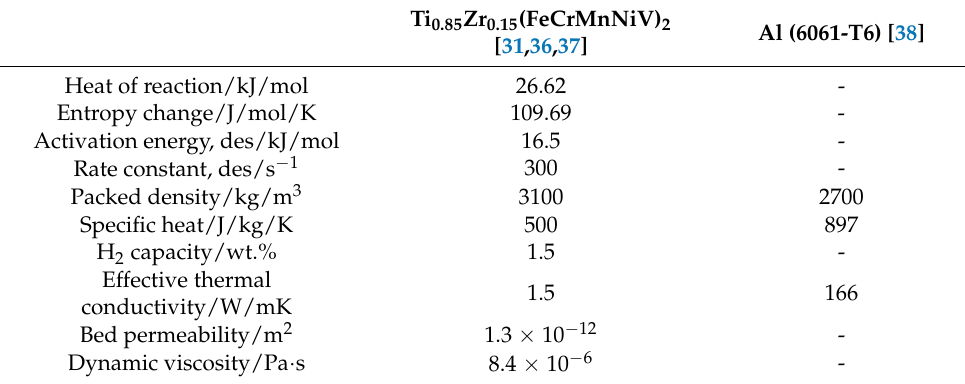
Figure 1. ( a ) Range extender based on an MHR-PCM system coupled with a PEMFC, ( b ) computational model of the MHR-PCM jacket: design A, ( c ) computational model of the finned-MHR-PCM jacket: design B. Table 1. Thermophysical properties of AB2-type hydride and reactor